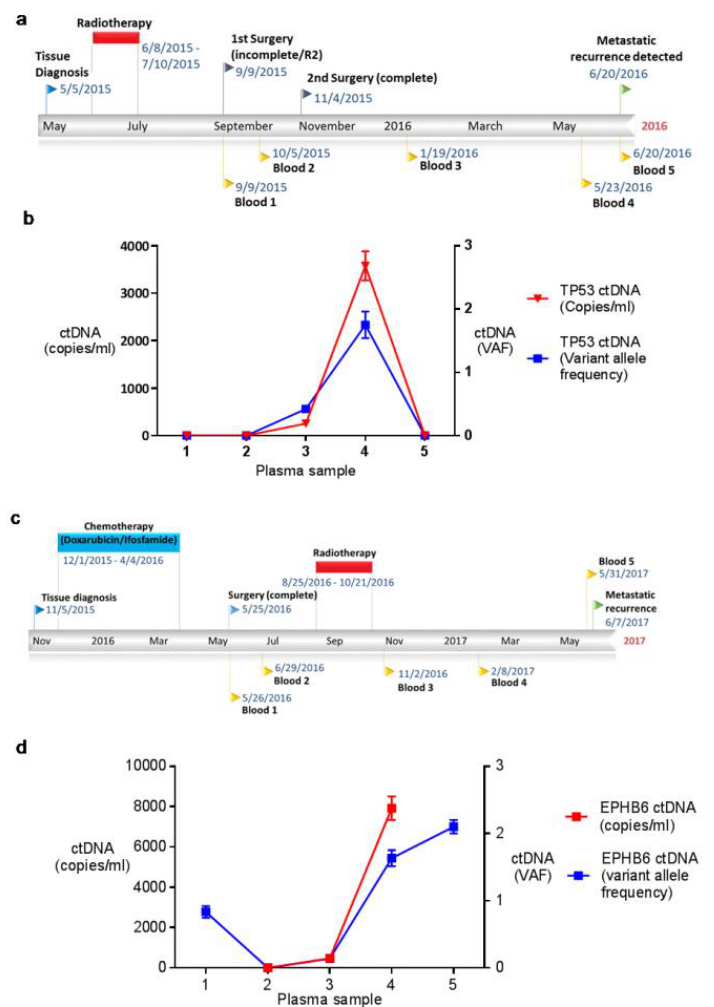
Figure 3. Management, outcome and ctDNA characteristics of patients 6 and 22. ( a ) The timeline of patient 6’s progress from diagnosis throughout treatment and follow-up until recurrence including dates of plasma samples collected. ( b ) shows the levels of circulating TP53 ; R306* identified in each plasma sample from patient 6. Circulating TP53 :R306 * was identified in samples 3 (VAF 0.42%, 254 copies / mL), and 4 (VAF 1.75% (SEM 0.15), 3580 copies / mL (SEM 307)). ( c ) The timeline of patient 22’s progress from the point of diagnosis throughout treatment and follow-up. ( d ) shows the levels of circulating plasma EPHB6 :G397R in each plasma sample from patient 22. Circulating EPHB6 :G397R was identified at a VAF of > 0.5% intra-operatively (VAF 0.85% (SEM 0.15) and in plasma samples 4 (VAF 1.6% (SEM 0.12), 7919 copies / mL (SEM 582)) and 5 (VAF 2.1% (SEM 0.1)). It was not possible to calculate the absolute number of copies of EPHB6 :G397R intra-operatively or in plasma sample 5 as total cfDNA levels were unavailable for these samples. In Figure 3b,d the right axis represents variant allele circulating fractional abundance and the left axis the variant allele concentration in copies / mL. Error bars showing standard error of the mean (SEM) are shown where biological replicates were